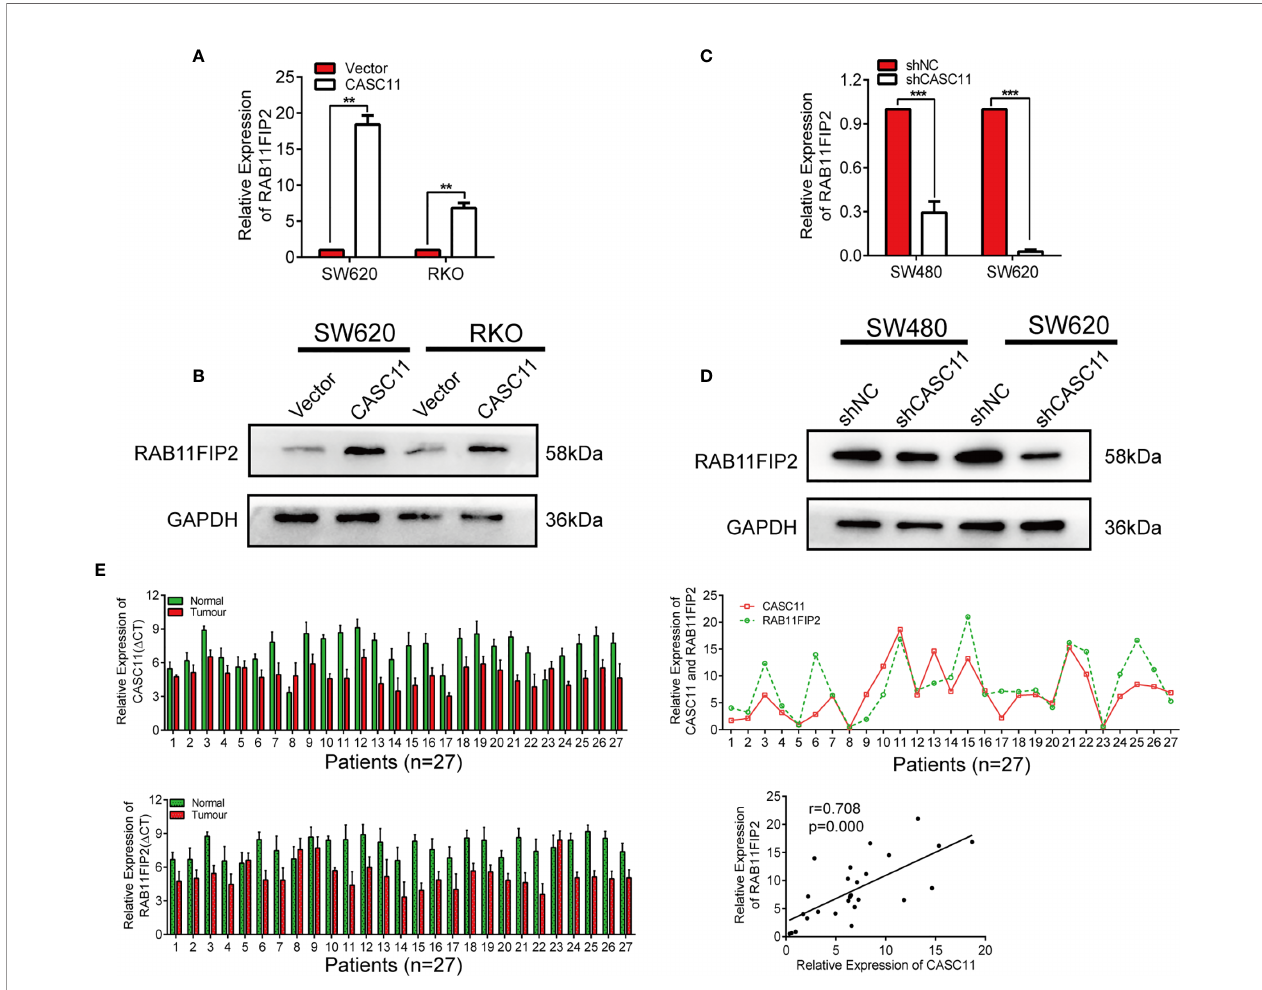
FIGURE 5 | CASC11 positively regulated RAB11FIP2 expression in CRC cells. (A-D) The relative expression levels of RAB11FIP2 in CRC cells transfected with CASC11 overexpression or interference reagents were determined by qRT-PCR and WB. (E) Expression of CASC11 and RAB11FIP2 in CRC tissues and the relationship between them (n=27). Left panel, qRT-PCR analysis of CASC11 and RAB11FIP2 expression in 27 paired human CRC tissues and adjacent normal tissues. Right panel, spearman correlation analysis showed a positive relationship between CASC11 expression levels and RAB11FIP2 mRNA levels in 27 CRC tissue samples. Error bars represent the means ± SD of 3 independent experiments. ** p < 0.01; *** p